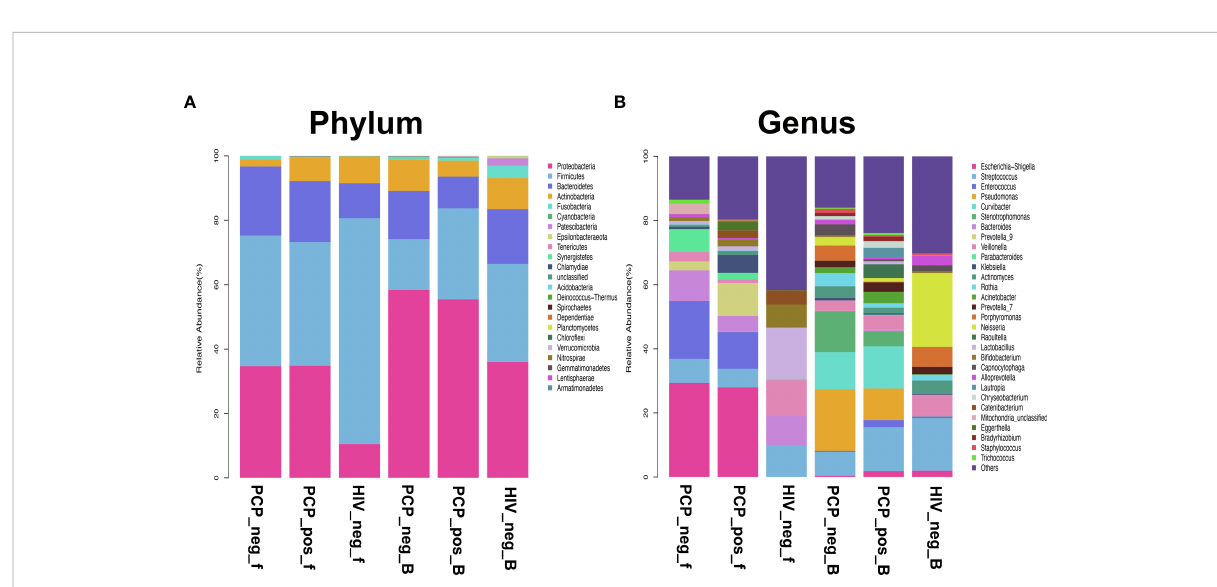
FIGURE 11 Comparison of phylum and genus level microbiota in the gut and lung. HIV_neg_f: gut microbiomes of HIV- group; PCP_pos_f: gut microbiomes of HIV+PCP+ group; PCP_neg_f: gut microbiomes of HIV+PCP- group; HIV_neg_B: lung microbiomes of HIV- group; PCP_pos_B: lung microbiomes of HIV+PCP+ group; PCP_neg_B: lung microbiomes of HIV+PCP- group. (A) Comparison of phylum level microbiota in the gut and lung. (B) Comparison of genus level microbiota in the gut and